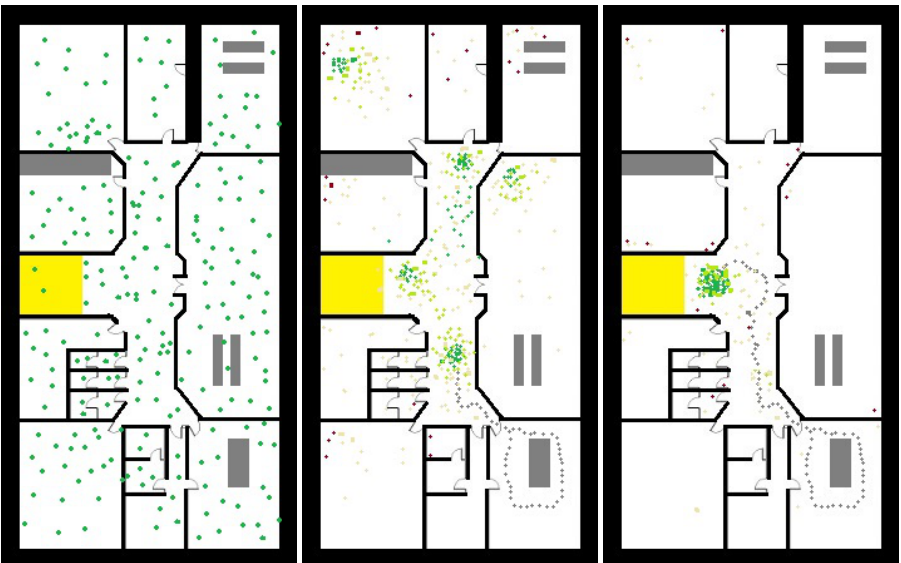
Figure 2. The basic particle filter process. ( Left ): particles are uniformly spread within the region of interest ( ROI ). ( Center ): after a short walk (about 12 m), the particles begin to cluster around locations with high likelihood. ( Right ): after a total walk of about 25 m, the particles converge to a single position cluster. Note: Some particles still are far from the main cluster, but the expected error (which corresponds to the area) is relatively